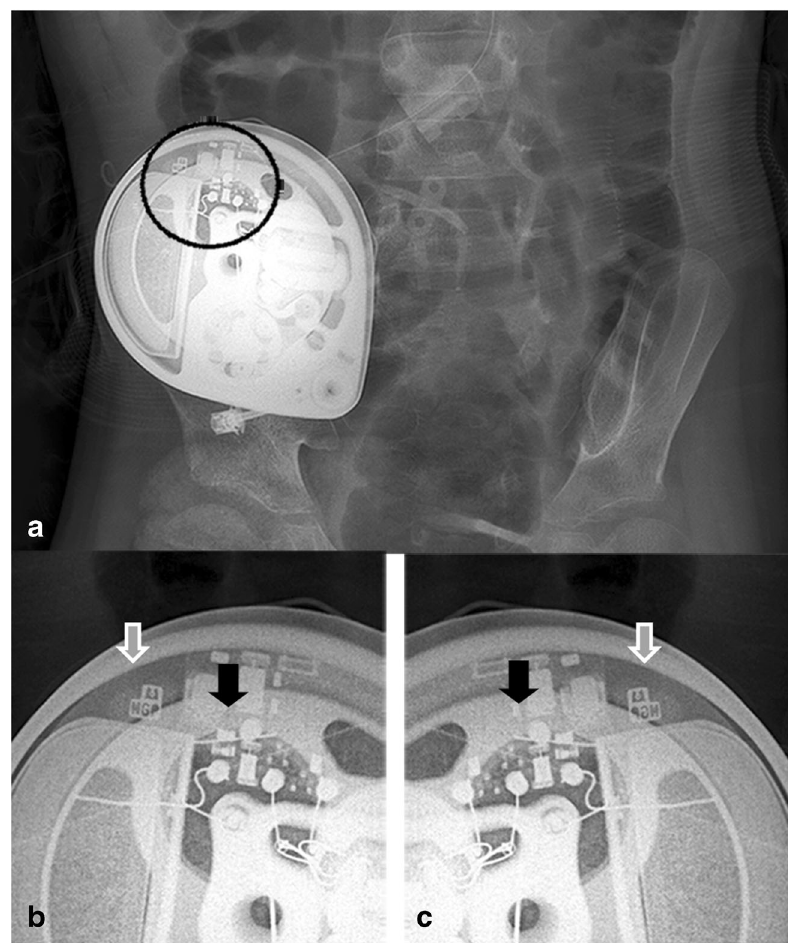
Fig. 7 A magnification view of the black circle ( a ) shows the radiopaque pump identifier consisting of the logo of the manufacturer and three alphabetic letters ( white arrow ) with visible electronics ( b ) into the left-hand side ( black arrow ). For (some) odd rotations of the pump to the vertical axis (Twiddler ’ s syn- drome), the pump is located on the head, which can be recognised by the logo in mirror image, and the electronics to the right-hand side (